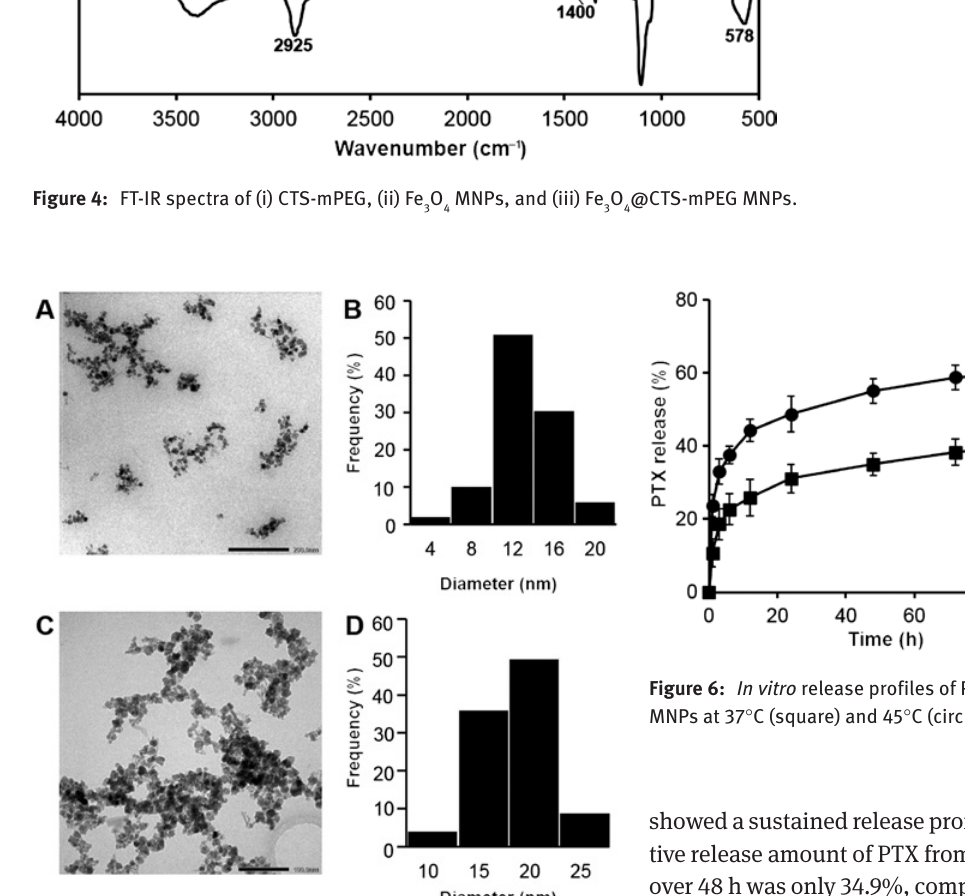
Figure 5: TEM images and particle size distributions of Fe and Fe O @CTS-mPEG (C, D), respectively. 3 4